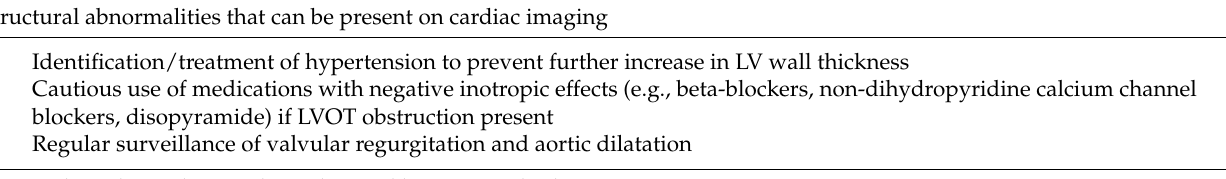
Table 4. Management of the cardiovascular manifestations of Fabry